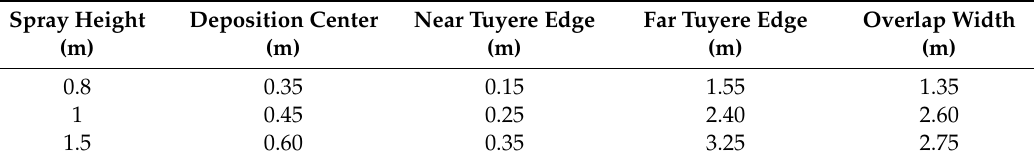
Table 5. Droplet drift distance of deposition center, near tuyere edge, far tuyere edge, and overlap width in different spray height, 0.8 m, 1 m, and 1.5 m.